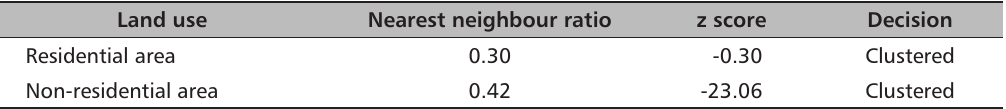
TABLE 4. Nearest neighbour analysis Land